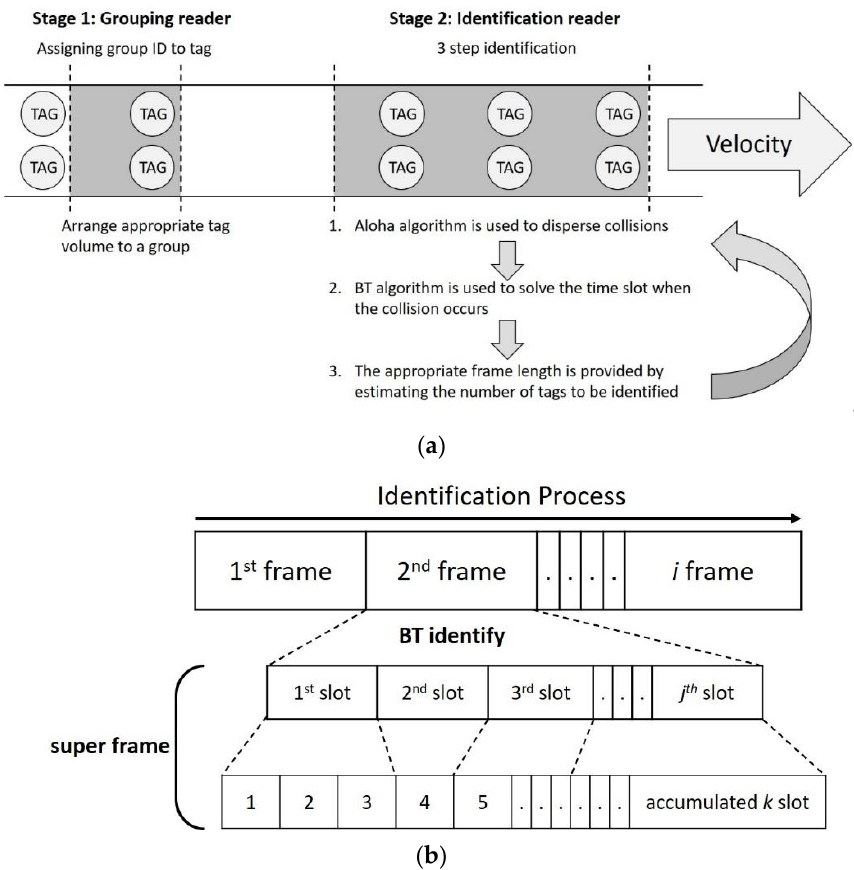
Figure 6. Concept of mobility aware binary tree algorithm (MABT): ( a ) MABT identification algorithm design; and ( b ) relationship between super frame and time slot.